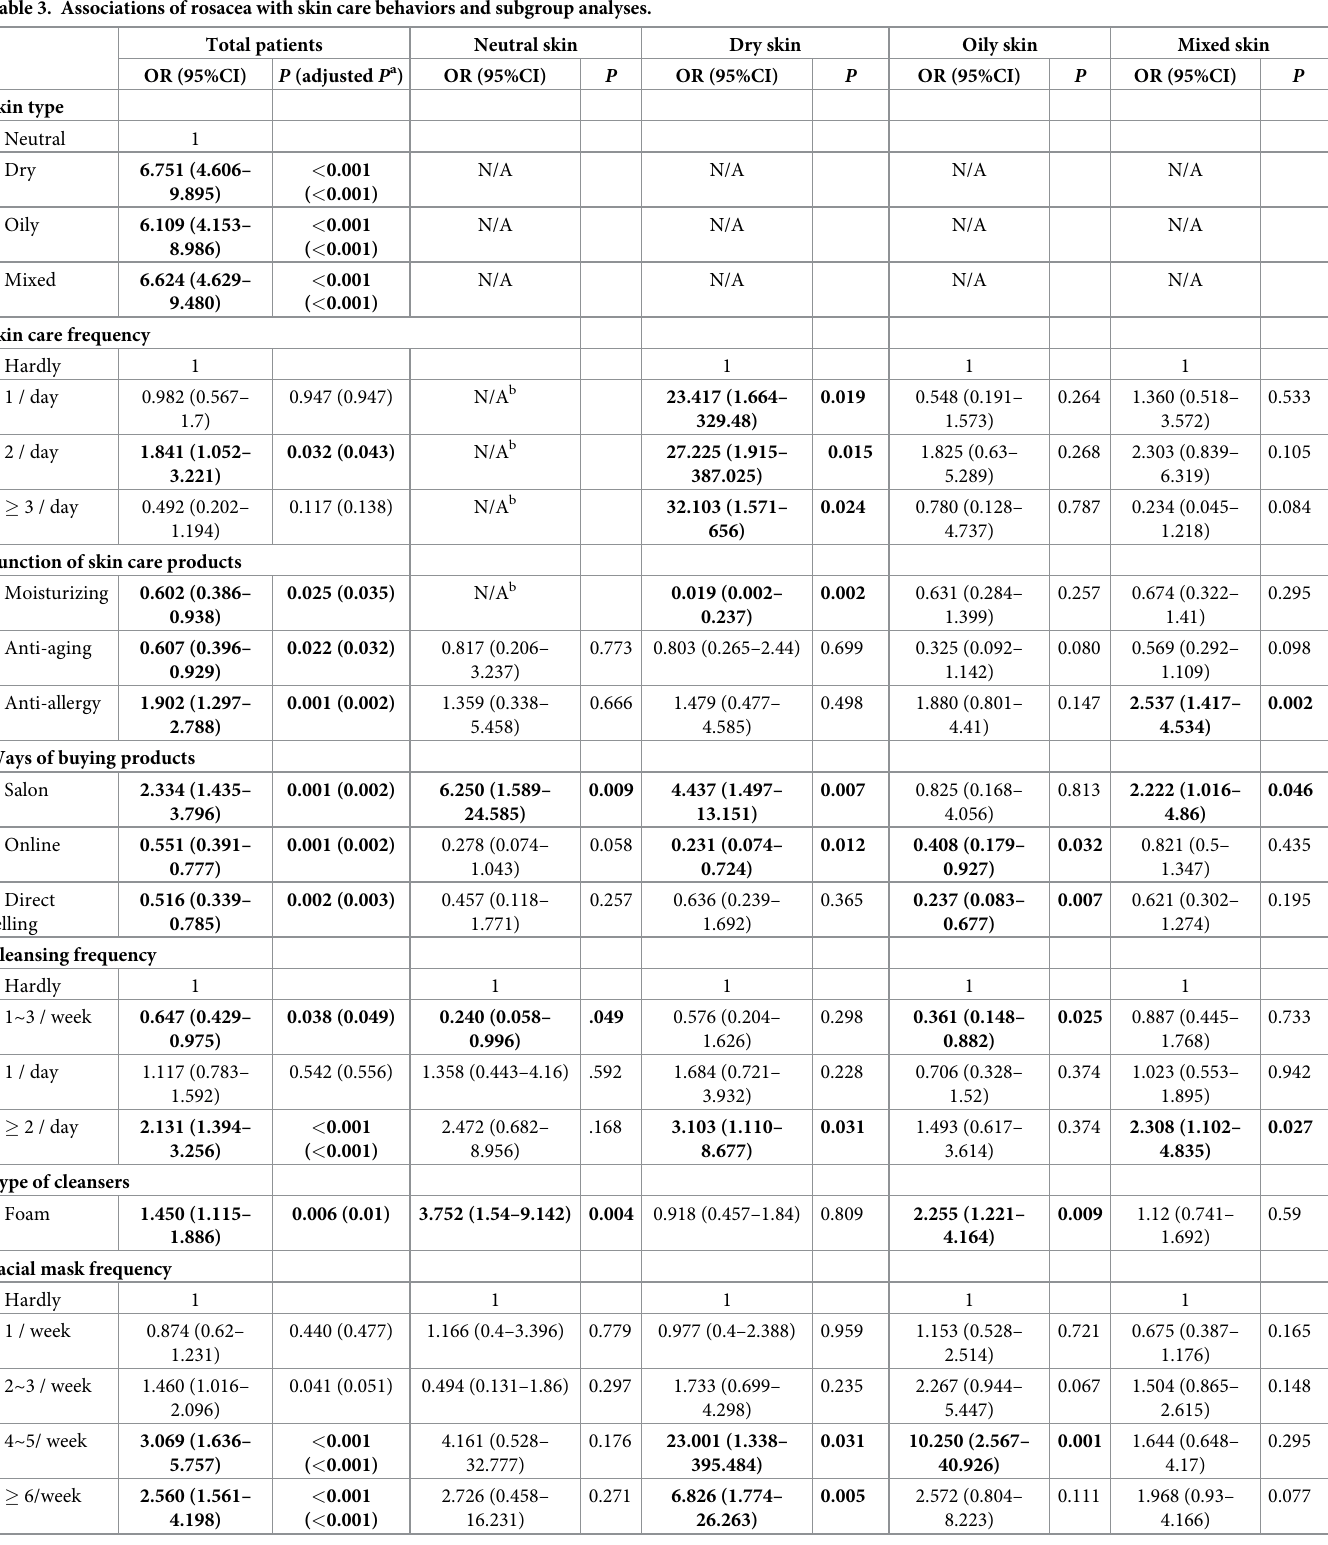
Table 3. Associations of rosacea with skin care behaviors and subgroup